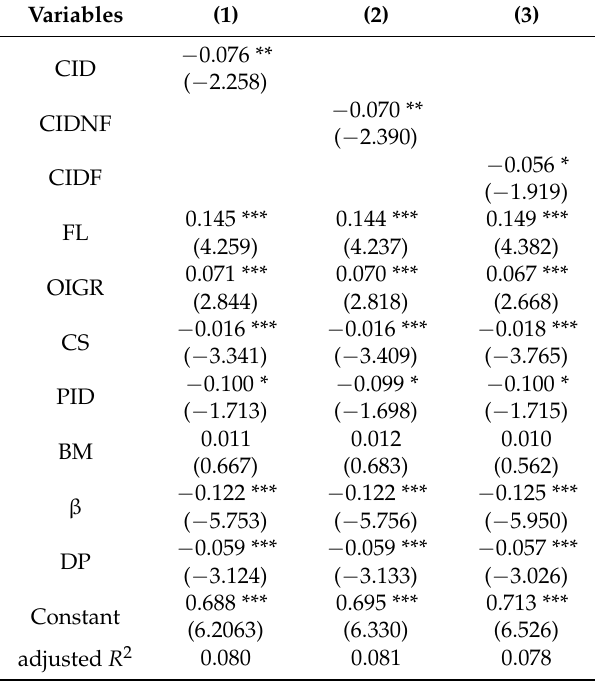
Table 4. Regression results of carbon information disclosure and cost of equity